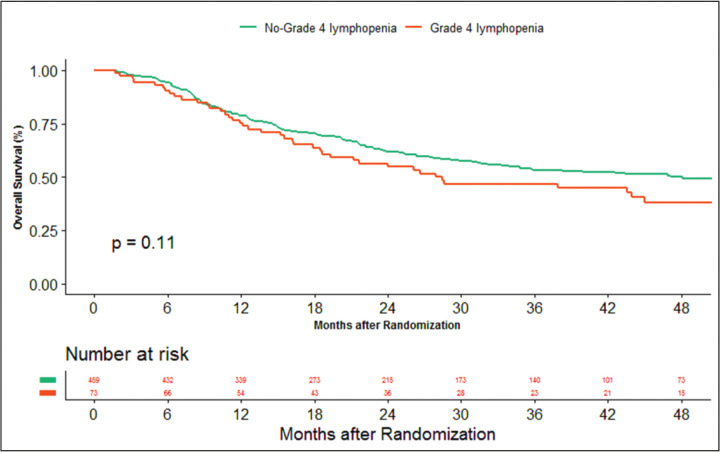
Kaplan–Meier curve showing overall survival in grade 4 (severe) and non-grade 4 lymphopenia (non-severe).